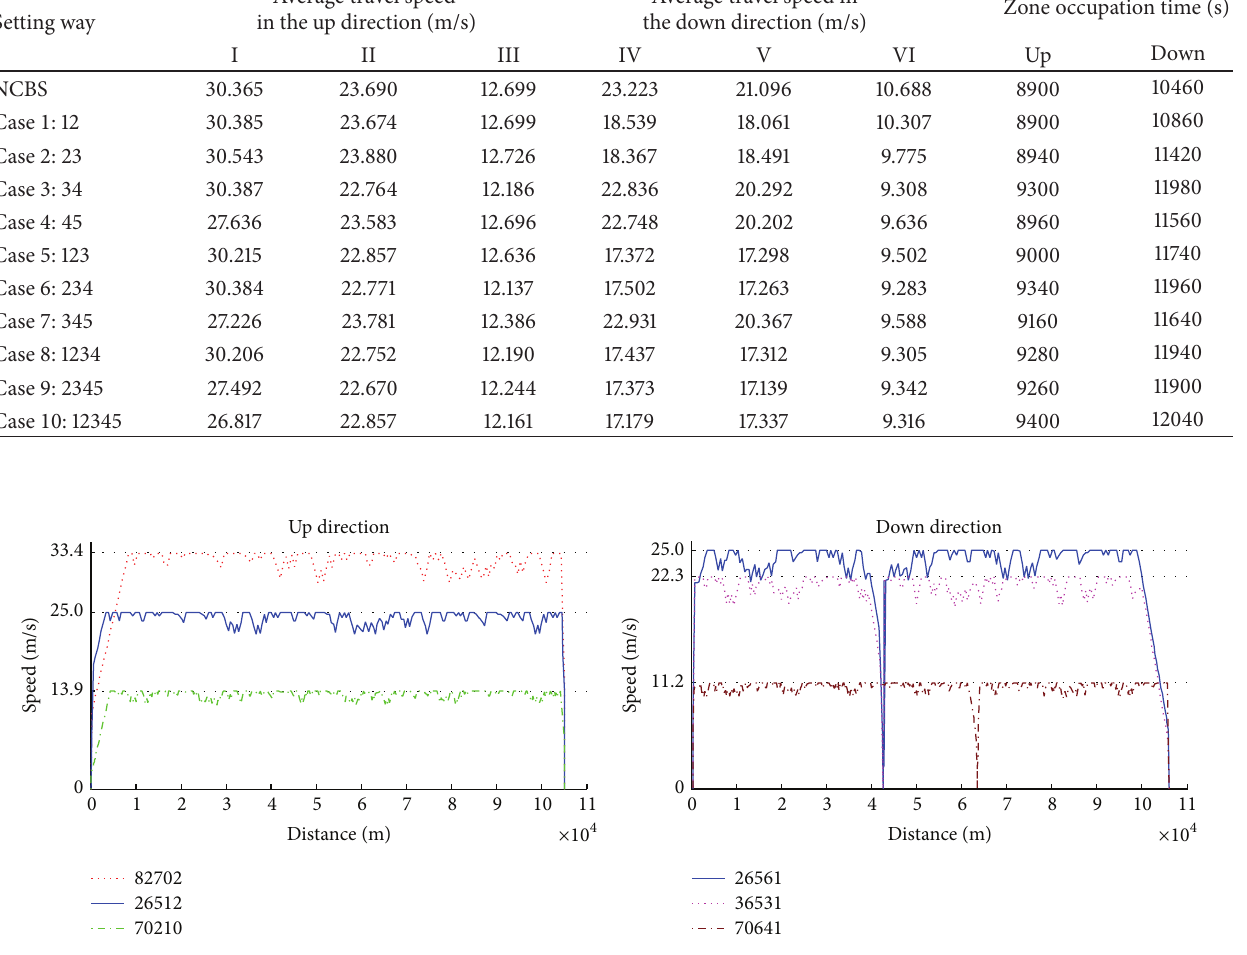
Figure 16: Train speed-distance curve (NCBS: blocking sections 2 and 3 in the left).